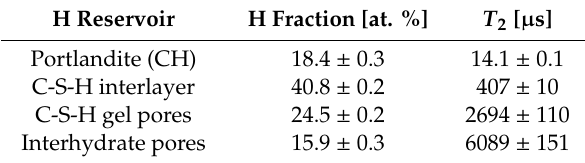
Table 2 . H reservoir distribution resulting from the evaluation of the solid-echo and CPMG decay results.